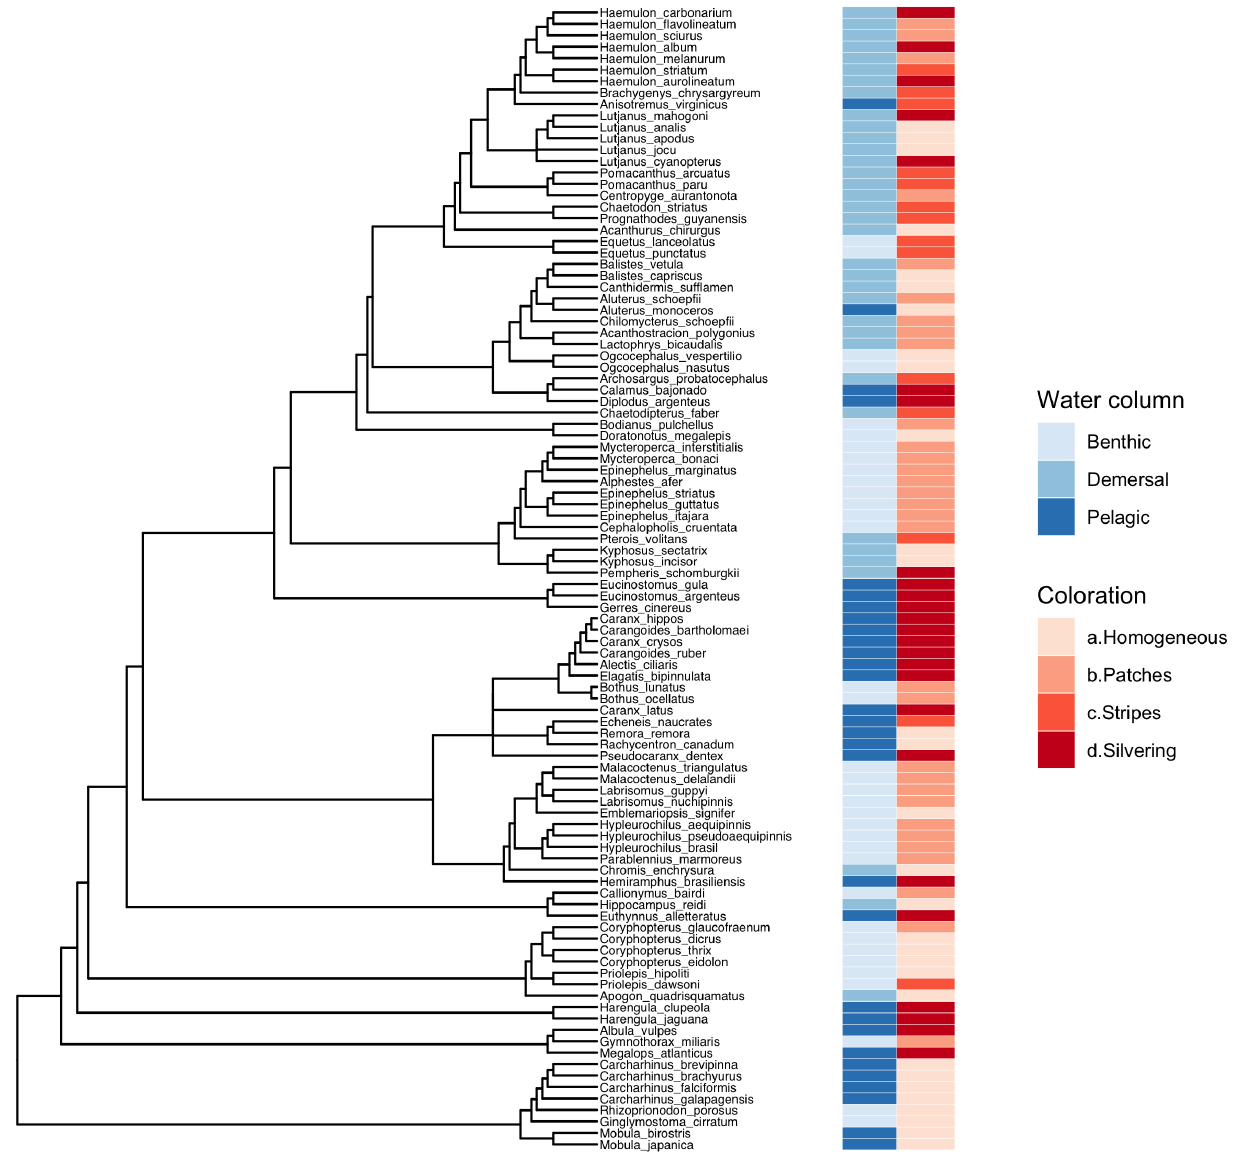
FIGURE 2 | Phylogeny of the 100 species used in this study generated from data in the Open Tree of Life. Branch lengths represent phylogenetic distance and were estimated by the Grafen’s method. Color bars denote the water column use (blue shades) and coloration pattern (red shades) we attributed to